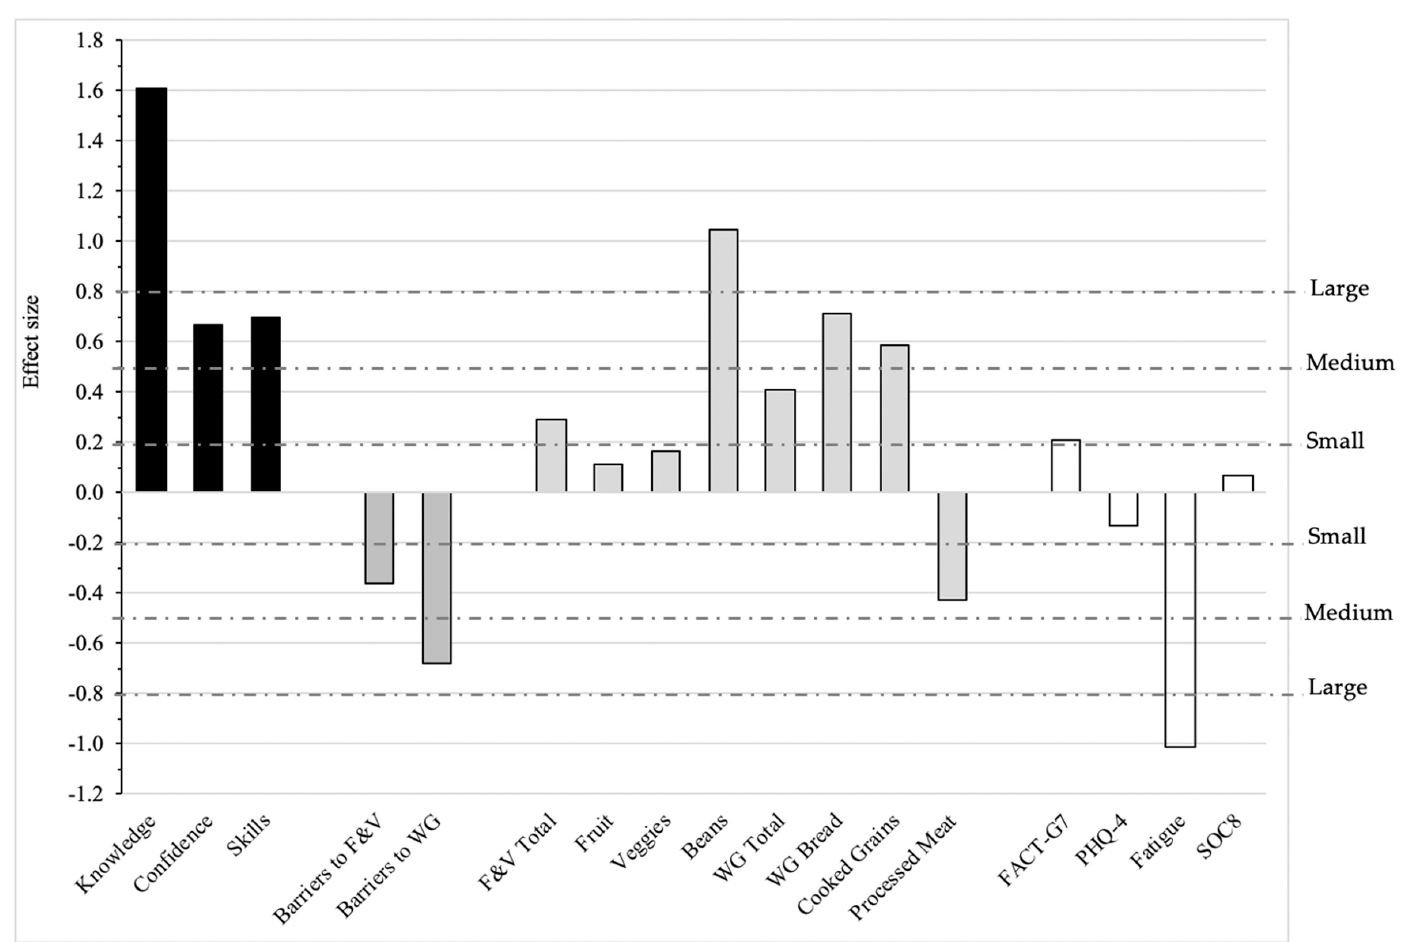
Figure 3. Effect size for the baseline to 9-week change in the Coping with Cancer in the Kitchen intervention group, as measured by the Effect Size statistic. The dotted lines correspond to small (0.2), medium (0.5), and large (0.8) effect sizes. WG: whole grain; F&V: fruit & vegetable; FACT-G7: a rapid version of the Functional Assessment of Cancer Therapy-General; PHQ-4: 4-item Patient Health Questionnaire for Depression and Anxiety; SOC8: NIH Toolbox ® Emotional Support Fixed Form Age 18 + v 2.0, Short Form